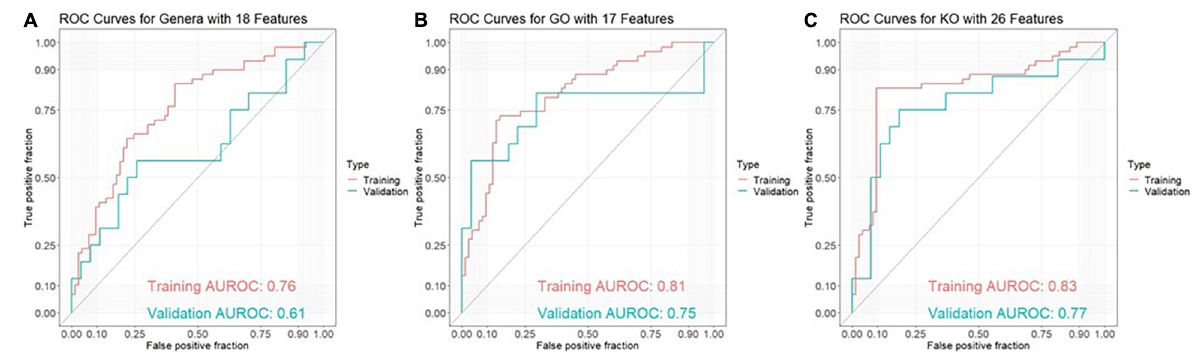
FIGURE 1 | ROC curves for discrimination between amyloid-positive Alzheimer’s disease (AD) patients and healthy controls in a training set (AD: n = 59, HC: n = 73) and an independent validation set (AD: n = 16, HC: n = 27) based on (A) 18 genera features, (B) 17 GO (Gene Ontology) features and (C) 26 KO [Kyoto Encyclopedia of Genes and Genomes (KEGG) ortholog]